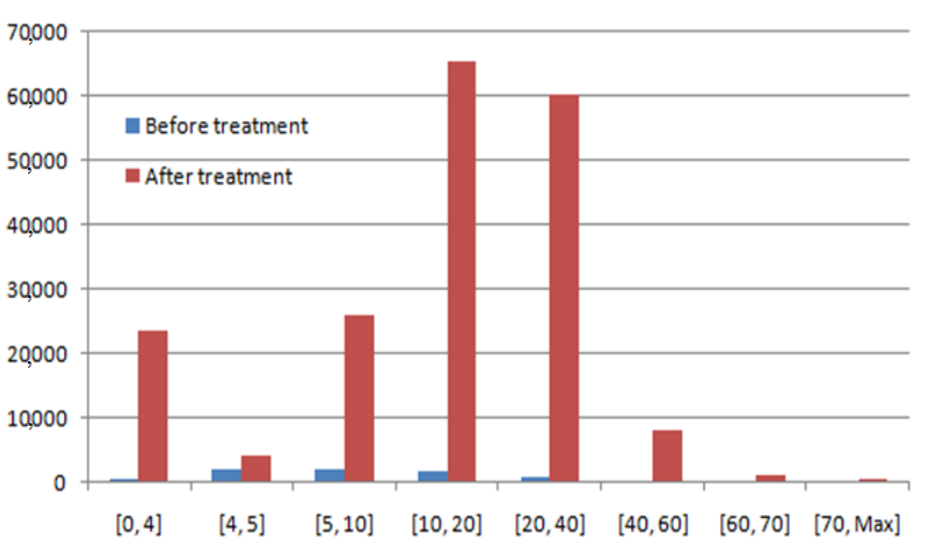
( b ) Figure 15. PUSCH physical throughout: ( a ) before treatment; ( b ) after treatment. The obtained values of PUSCH physical throughout before and after treatment are given in Table 5: Table 5. PUSCH physical values before and after treatment. Range (Mbps)